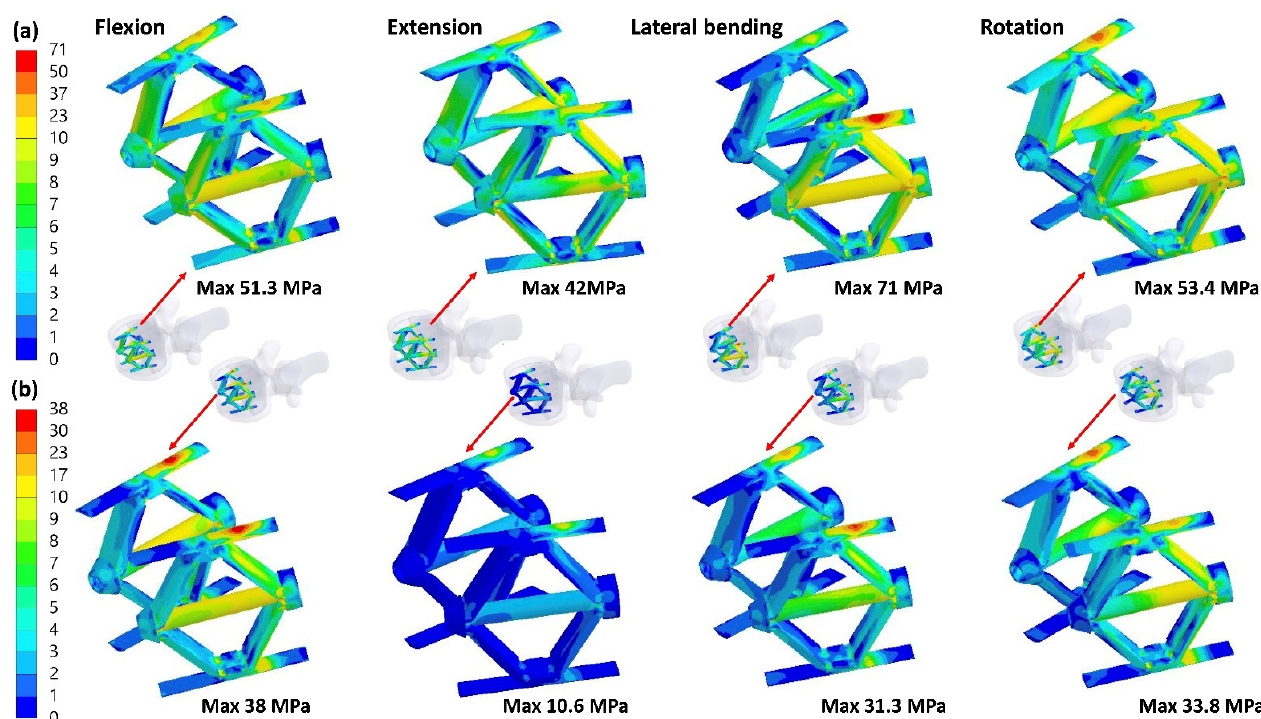
Figure 10. The equivalent stress of the SpineJack without ( a ) and with ( b ) the PI.